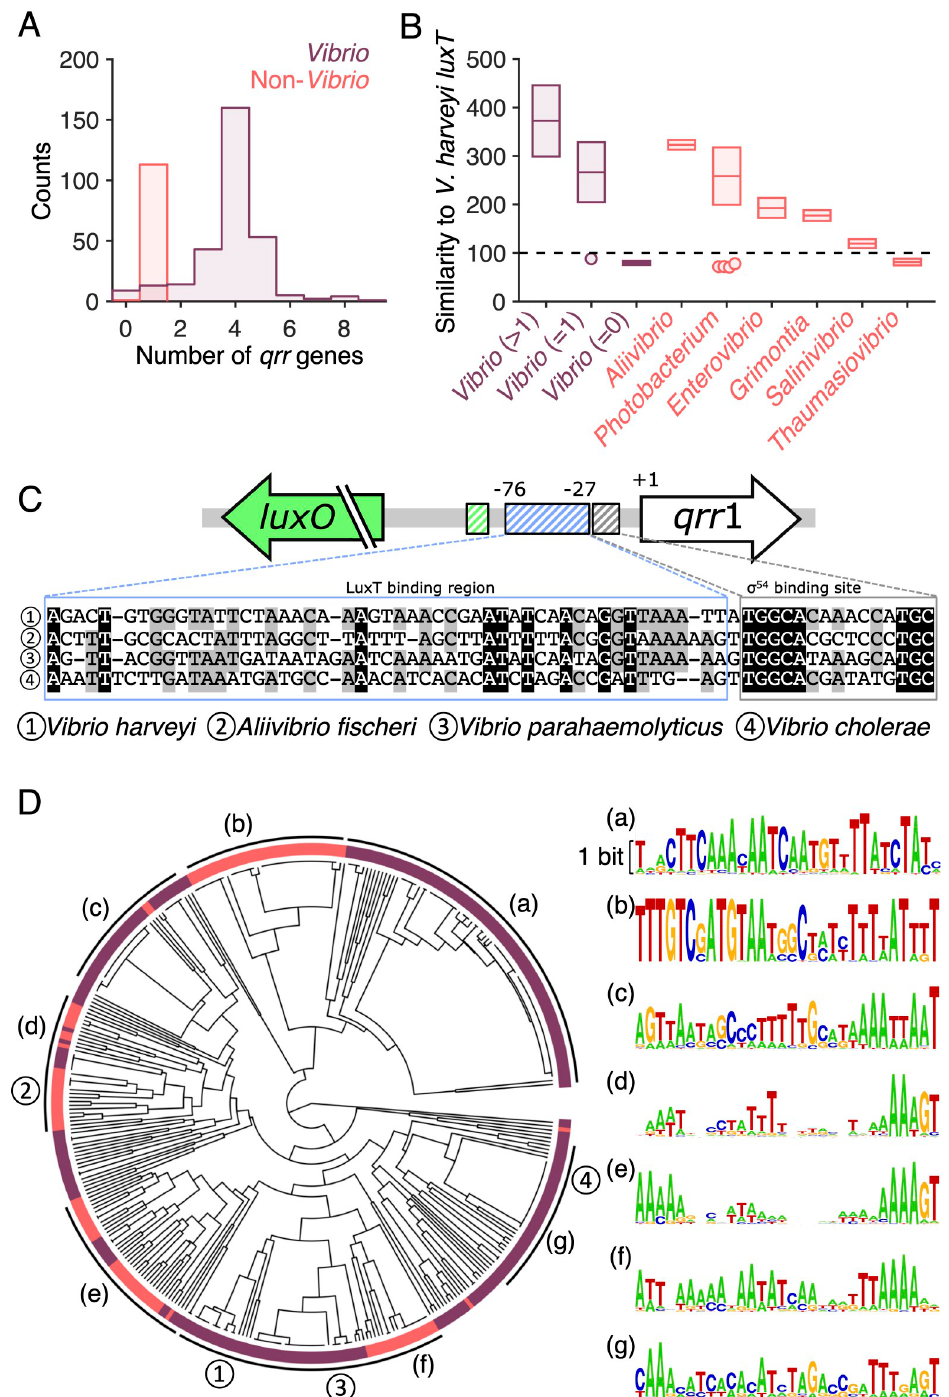
Fig 7. Co-occurrence of luxT and qrr genes and possible LuxT regulation of qrr 1 across the Vibrionaceae . (A) Histogram of the number of qrr genes in Vibrio (purple) and non- Vibrio (red) members of the Vibrionaceae family. (B) Highest similarity score to V . harveyi luxT for genes in the indicated genera. The vibrios are divided into three groups based on the number of qrr genes in their genomes (indicated by the numbers in the parentheses). The similarity scores, which quantify the weighted DNA sequence similarities based on the standard scoring matrix NUC44, were obtained from alignments of genome sequences to the query probe using the Smith-Waterman algorithm (see Methods). The black dashed line indicates the cutoff used for the similarity score. Boxes show